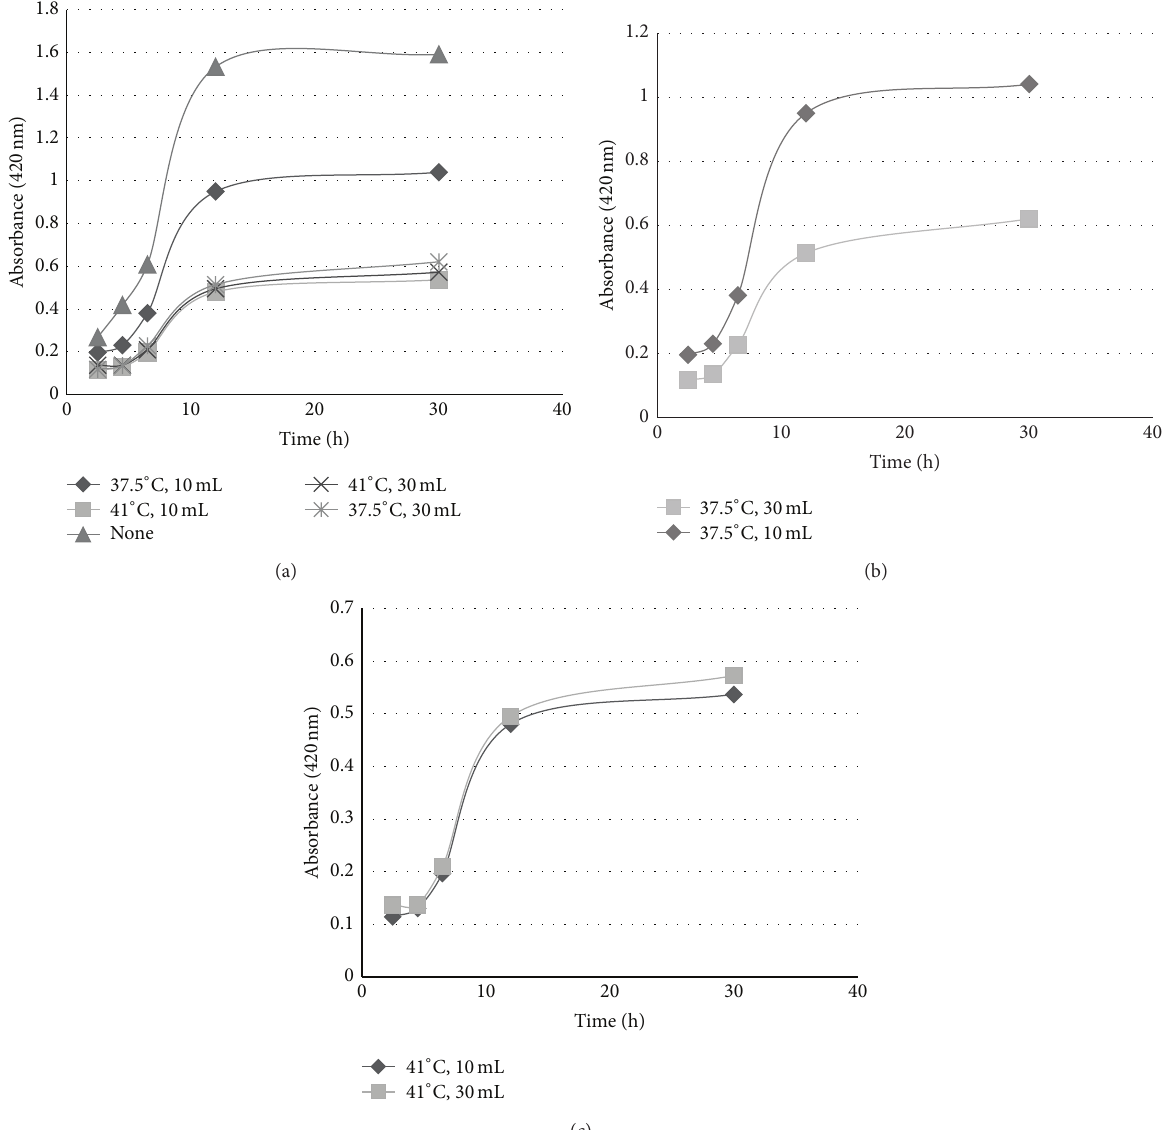
Figure 3: Microbial growth in different extracts added to liquid